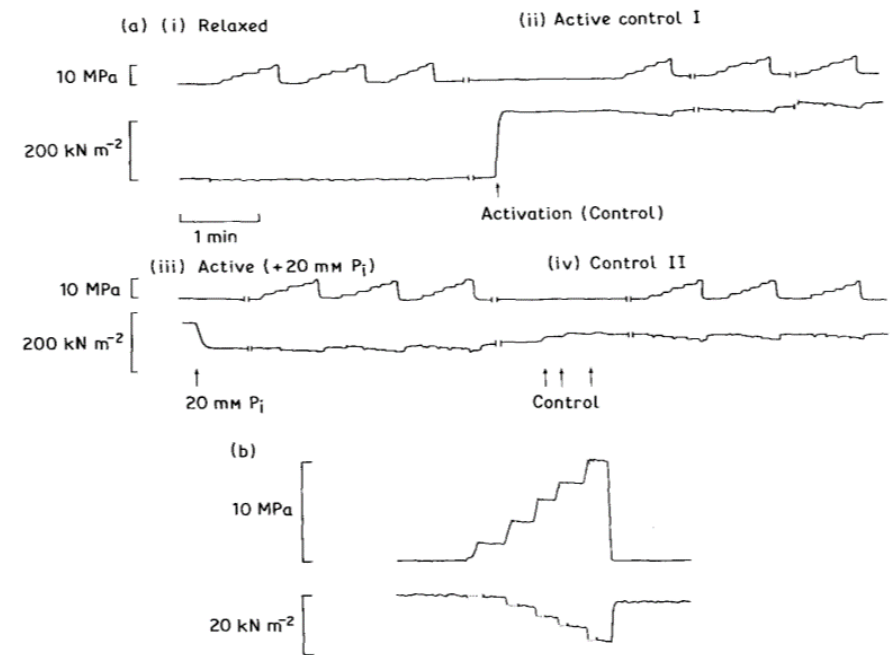
Figure 5. ( a ) Strip chart record showing the experimental protocol: the upper trace shows pressure and the lower trace, tension. The pressure sensitivity of tension was first examined when the fibre was relaxed ( i ). The fibre was then maximally Ca-activated in control solution (no Pi) and again the effect of pressure recorded ( ii ). Taking this to be zero time, the response to pressure was then recorded in test solution (+ 20 mM Pi) after 14 min ( iii ) and again in control solution ( iv ) after 22 min. Arrows indicate the points at which the solution was changed. Note that the sections illustrated are from a continuous record: the steady tension was depressed by 40% on exposure to Pi and then recovered to 80% of the original tension after Pi removal. Under each condition ( i – iv ) the steady tension at high pressure was normalized to the mean tension recorded at atmospheric pressure immediately before and after a series of pressurizations. ( b ) A computer stored records of tension and pressure during an active contraction; the actual measurements were made from them (taken from Fortune et al., [9]).